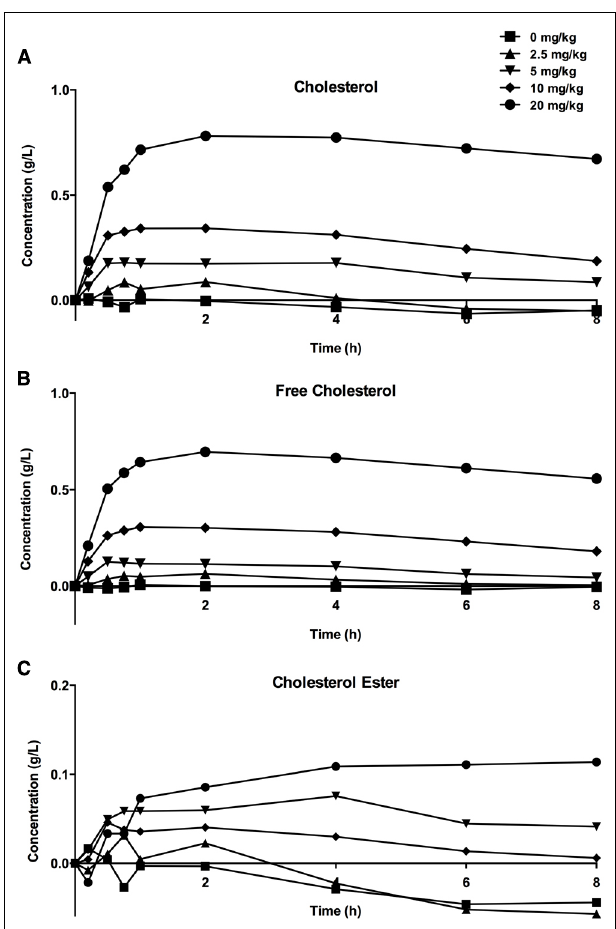
FIGURE 3 | Increase in plasma total (A), unesterified (B), and esterified (C) cholesterol levels following infusion of CER-001. CER-001 was infused into fasted rabbits at doses of: 0 (squares), 2.5 (triangles), 5 (inverted triangles), 10 (diamonds) or 20 (circles) mg/kg. There were three animals per group. At various times post dose, plasma total, unesterified and esterified cholesterol levels were measured. Baseline values were subtracted to determine the increase in cholesterol levels. The baseline values ranged from 0.41 to 1.08 g/l for total cholesterol, from 0.13 to 0.3 g/l for unesterified cholesterol, and from 0.28 to 0.78 g/l for esterified cholesterol. By 30–34 h post dose the values had returned to a value at or below